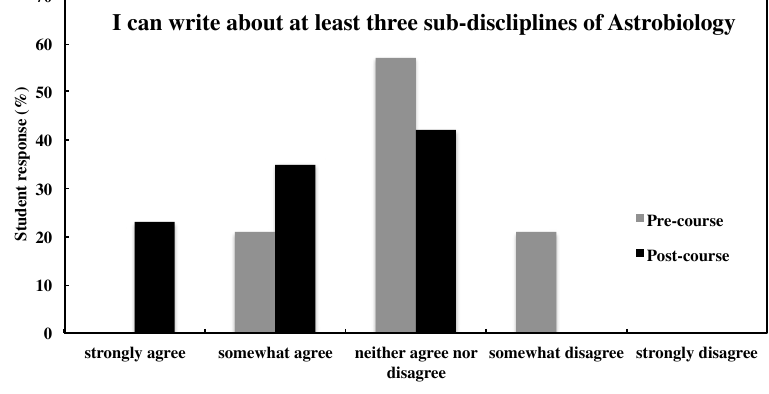
Table 2. The four-year numerical data about Astrobiology course.